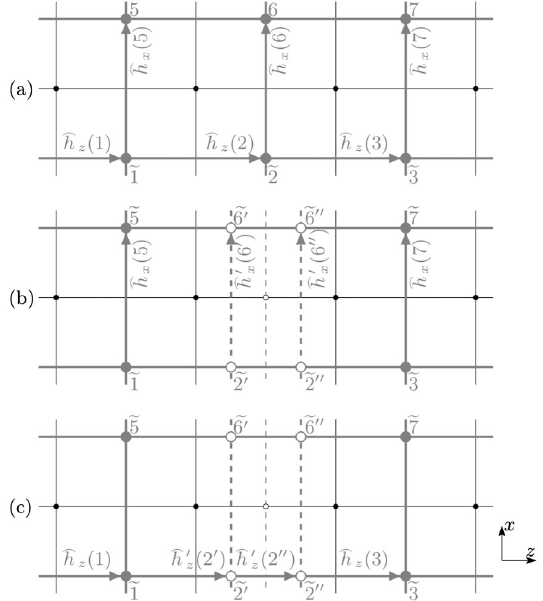
3. The refinement of the primary grid and the assignment of electric grid voltages to the refined edges is depicted in the x - z plane. In (a) the initial situation is shown. In (b) and (c) the middle cell was refined, introducing an additional grid line (dashed). Thus, two nodes 2 0 and 6 0 (circles) are inserted. All voltages that are new or require an update of their value are marked with a prime. In (b) the position of the new electric grid ð 2 0 Þ is shown. The voltage ̑ e voltage ̑ e 0 x coordinate, has to be split into the two voltages ̑ e 0 as shown in (c).